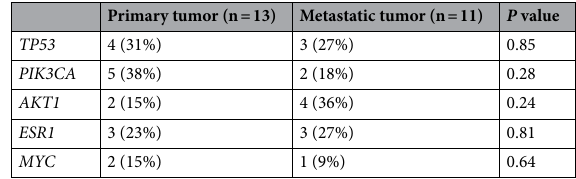
Table 5. Number of patients harboring somatic gene alterations according to the site of the sample used for clinical